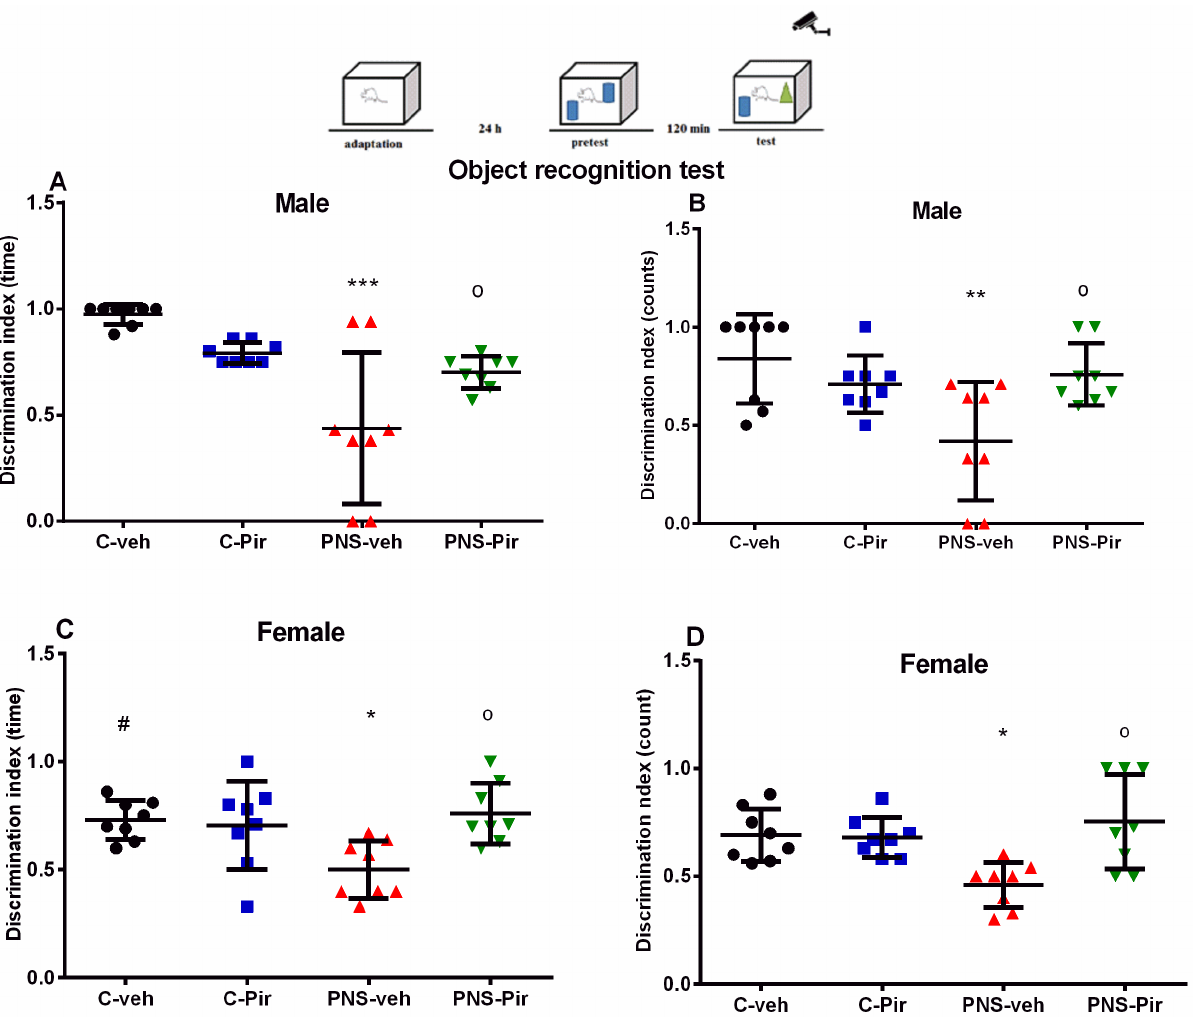
Figure 1. The chronic Piromelatine treatment exerted a beneficial effect on cognitive impairment in male offspring with a history of prenatal stress in the ORT test. Three-way ANOVA indicated a main effect of PNS [F 1,54 = 11.374, p < 0.001], PNS x Drug interaction [F 1,54 = 15.971, p < 0.001] and PNS x sex interaction [F 1,54 = 5.736, p < 0.021] on discrimination index (DI) (time) ( A , C ) and PNS x drug interaction [F 1,54 = 12.929, p < 0.001] on DI (counts) (B, D ). Data are presented as means ± SEM: * p < 0.005 vs. C-veh, o p < 0.005 vs. PNS-veh, # p < 0.05 vs. male.